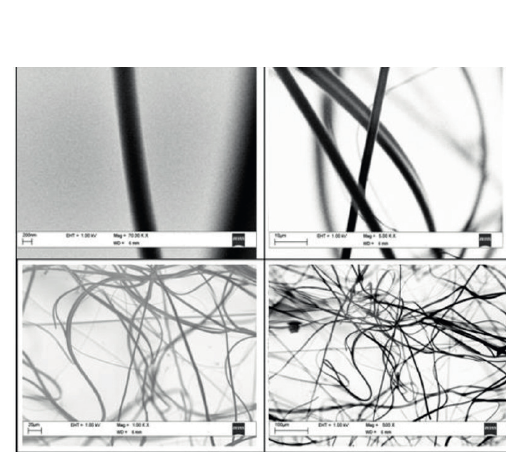
: 0.2% Zn Fig 8: SEM image of 15% PVP: 10% TiO 2 nanofibers